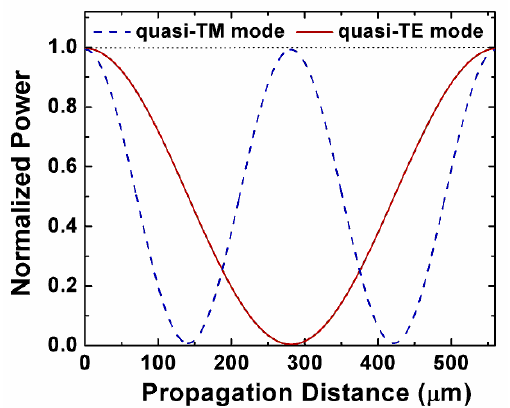
Figure 6. Normalized power exchange of the quasi-TM and quasi-TE modes at the bar port.